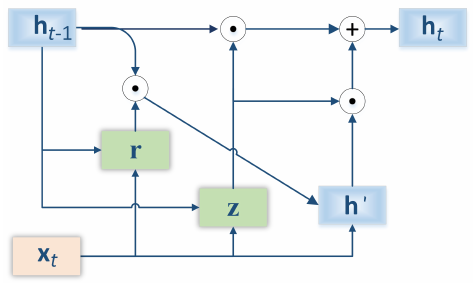
Figure 10. Flow chart of status transmission for GRU